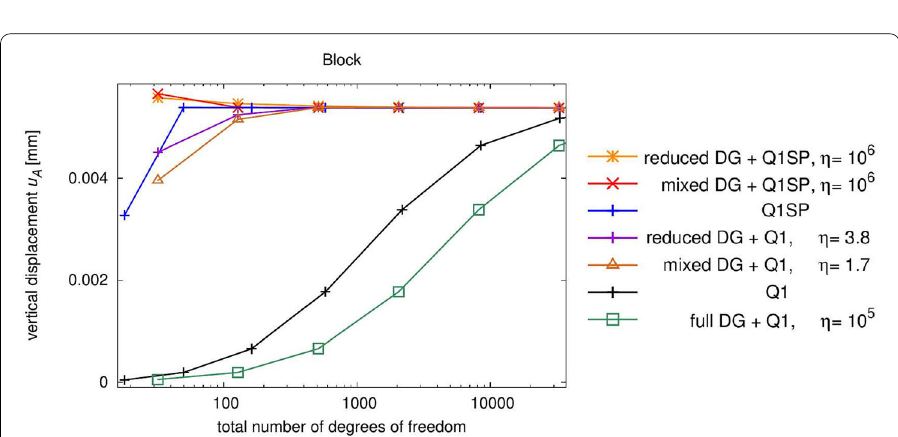
Fig. 9 Vertical displacement of the point A as a function of the total number of degrees of freedom for Q1, Q1SP, DG and their